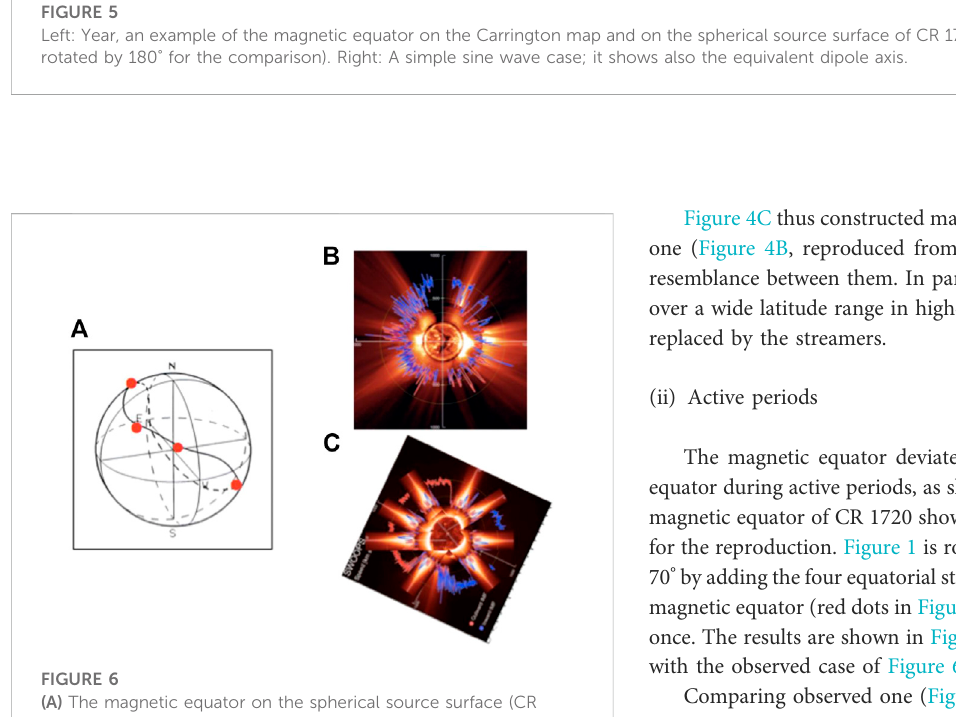
absent on one side in Figure 1, indicating that the equatorial streamer is perhaps intermittently present along the magnetic equator.